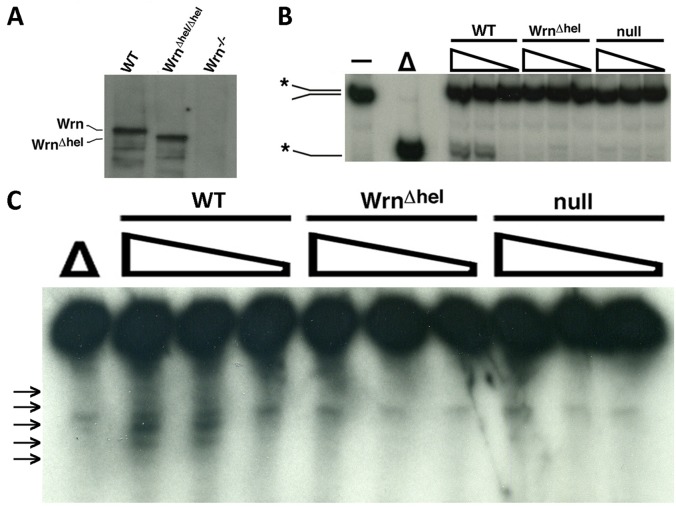
DNA helicase and exonuclease activities of the immunoprecipitated WT and mutant Wrn protein.(A) Example of a western blots is presented. WT, Wrn
Δhel/Δhel and Wrn
-/- MEFs were lysed and the Wrn proteins were immunoprecipitated with a mouse anti-Wrn monoclonal antibody. The immunoprecipitates were analyzed by immunoblotting with a rabbit anti-Wrn polyclonal antibody. (B) DNA helicase activity of the immunoprecipitated Wrn proteins. The position of the double strand and single strand radioactive structures are indicated with an asterisk. The “-”lane represents the undenatured double strand radioactive structure. The “Δ” lane represents heat-denatured DNA. (C) Nuclease activity of the immunoprecipitated Wrn proteins. The positions of the cleaved fragments are indicated on the left by arrows. Ten, five, and zero μL of bead solutions containing the immunoprecipitated proteins were used for the enzymatic reactions. The “Δ” lane represents heat-denatured DNA.